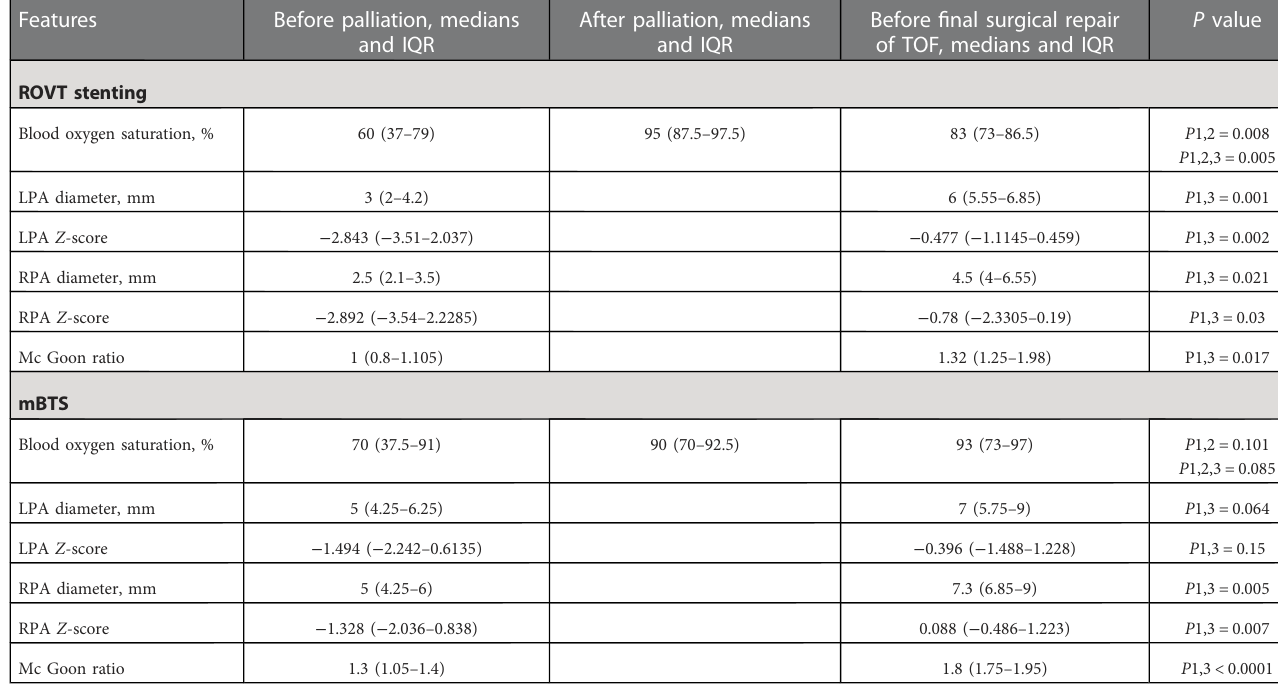
TABLE 3 Clinical and cardiovascular CTA features of the patients before and after palliation and before fi nal surgical repair of TOF.